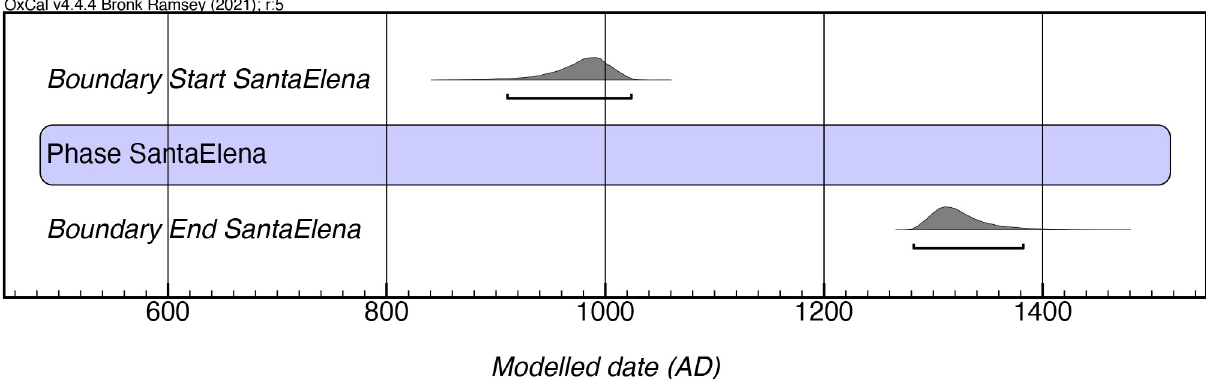
Fig 14. Modeled date ranges for the Santa Elena style in Puerto Rico. Probability distributions indicate modeled 2 σ (95.4%) confidence intervals for beginning and end of phase.